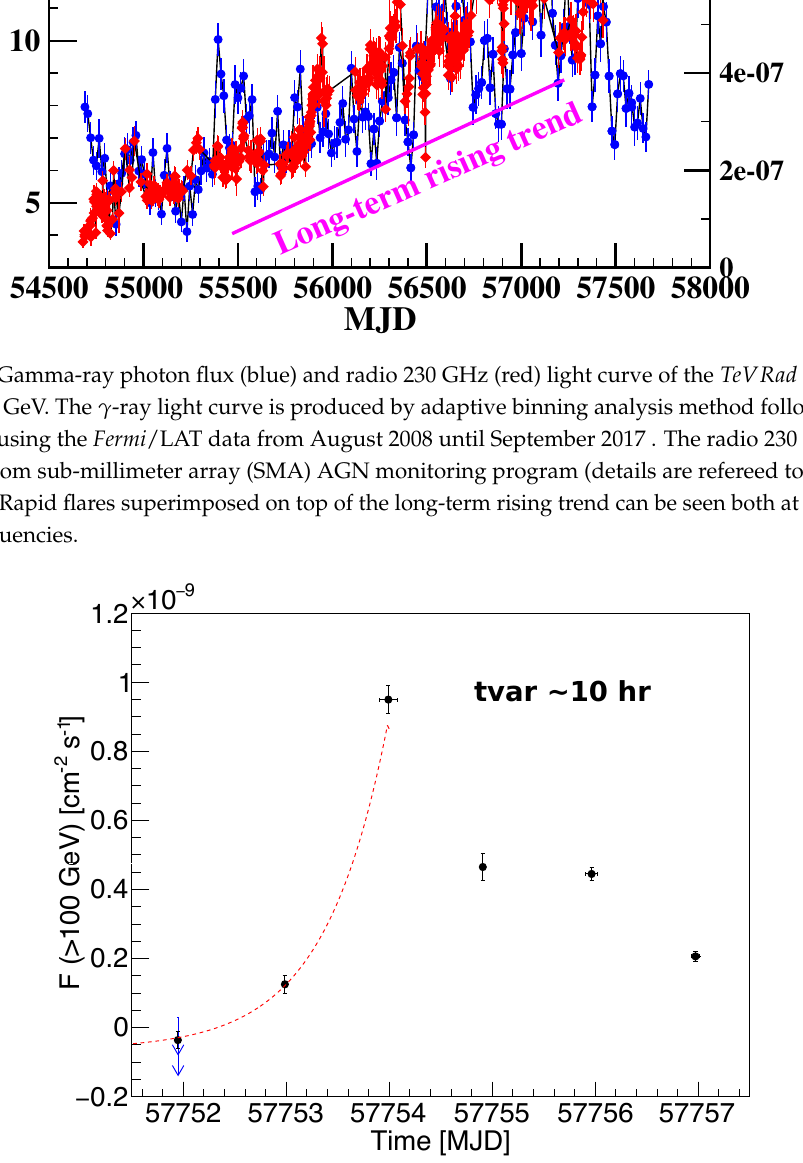
10 h. Long-term variations at γ -rays are ∼